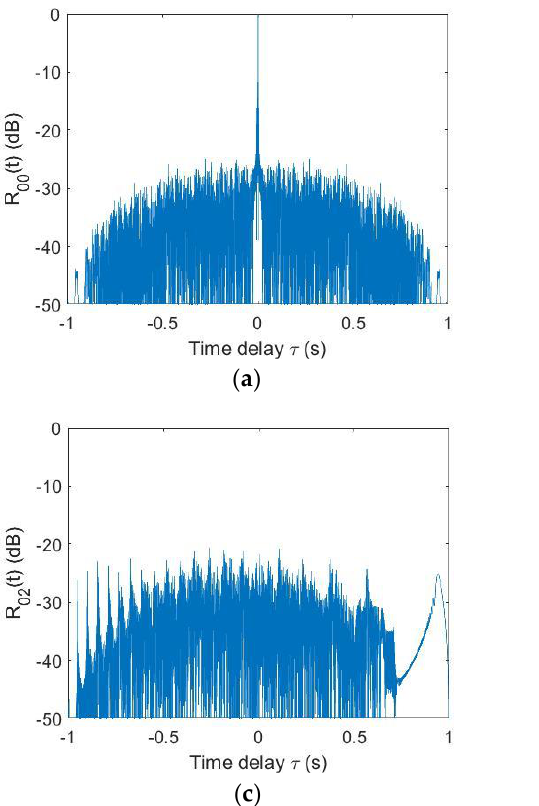
Table 1. Simulation parameters.